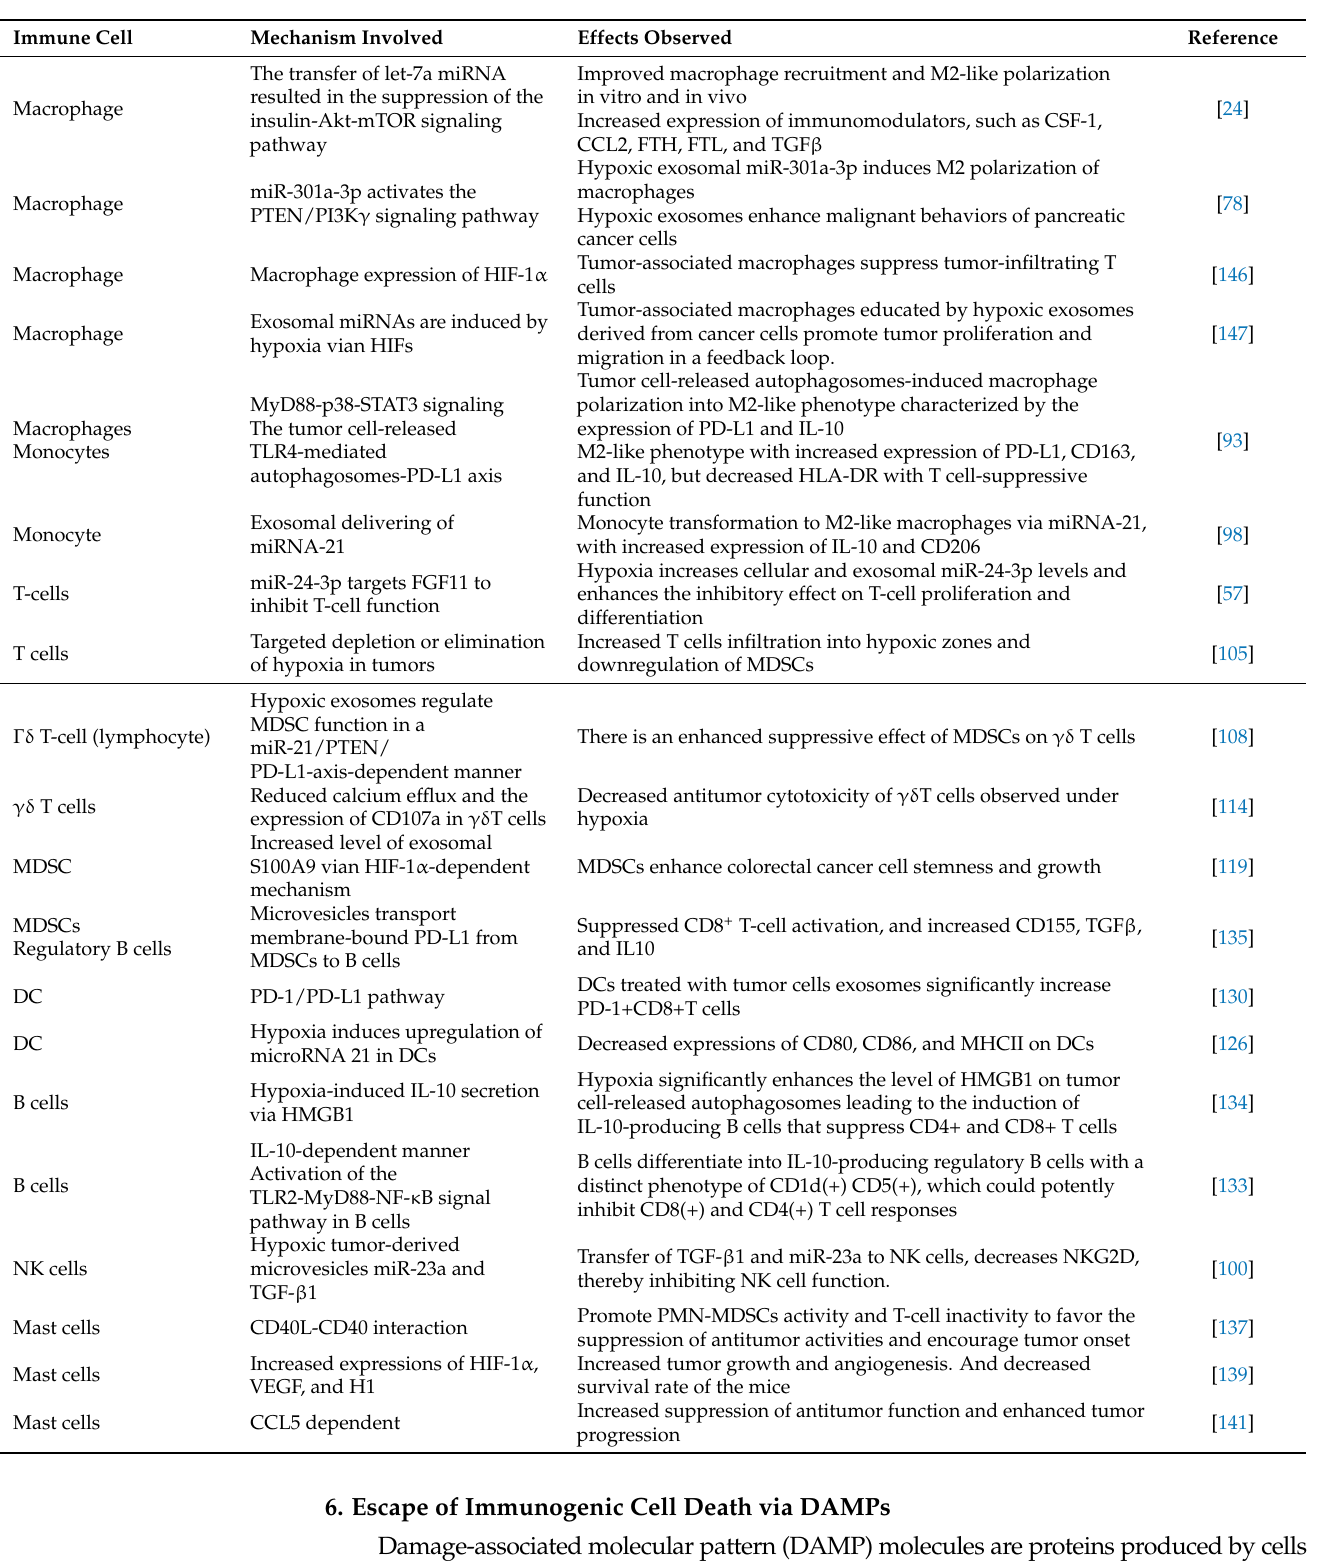
Table 2. Observed effects of hypoxic exosomes on various immune